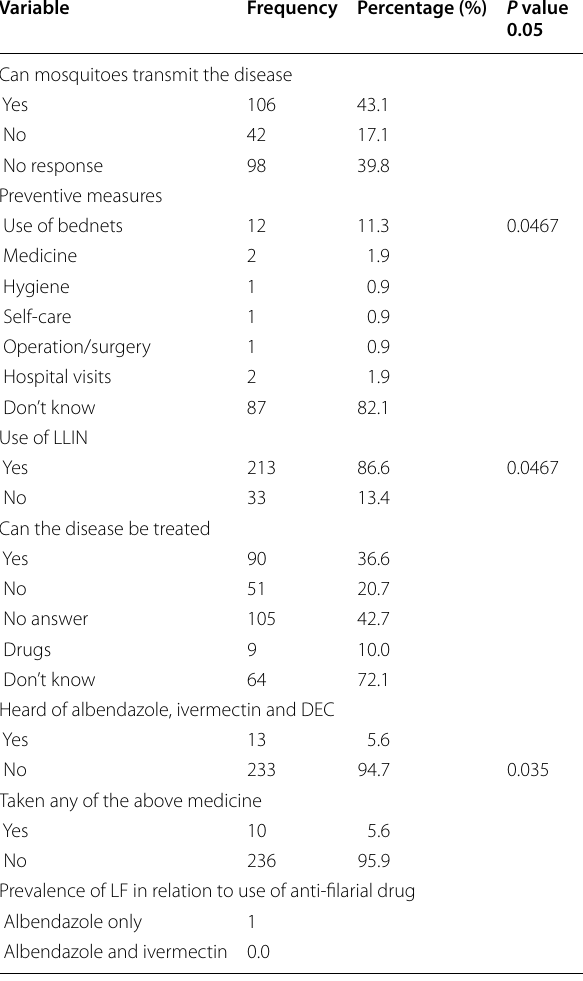
Table 7 Respondents’ knowledge on prevention and treatment of lymphatic filariasis